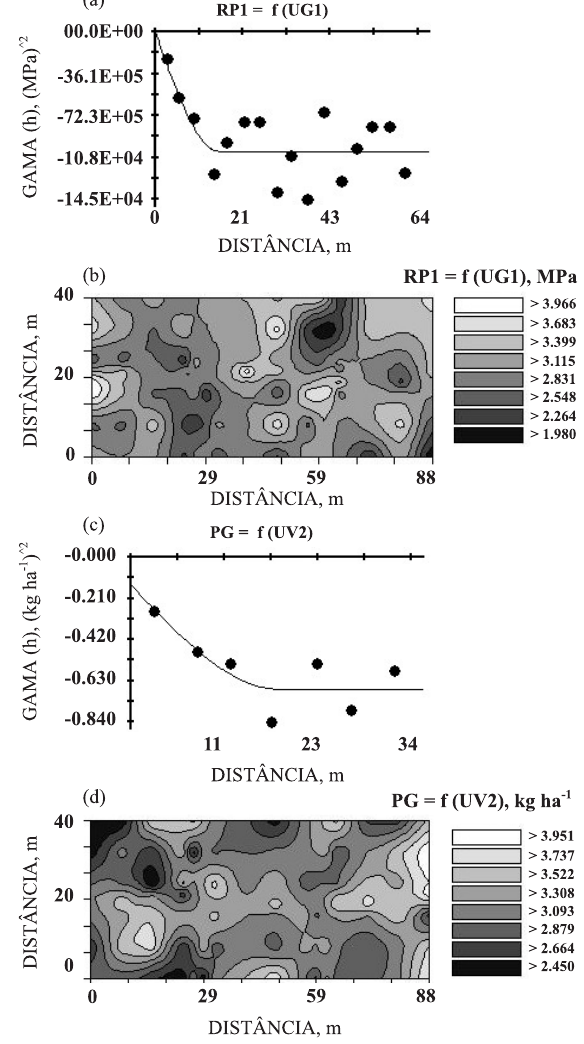
Figura 3: Semivariograma cruzado e mapas de co- krigagem da produtividade da soja e de alguns atributos físicos de um Latossolo Vermelho distroférrico de Selvíria